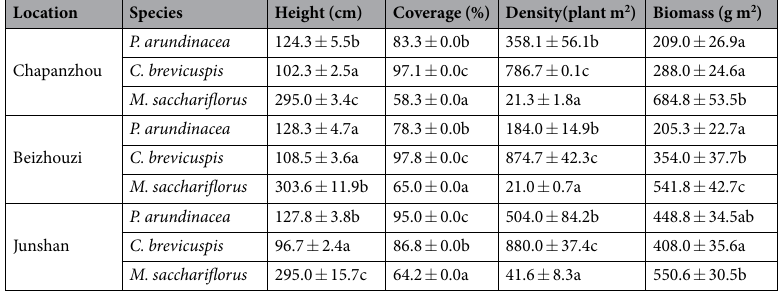
Table 1. Community characteristics of wetland plants (means ± SE) distributed along an elevation gradient of 3 lakeshore areas in Dongting Lake, China. Different letters indicate significant differences among treatments at the 0.05 significance